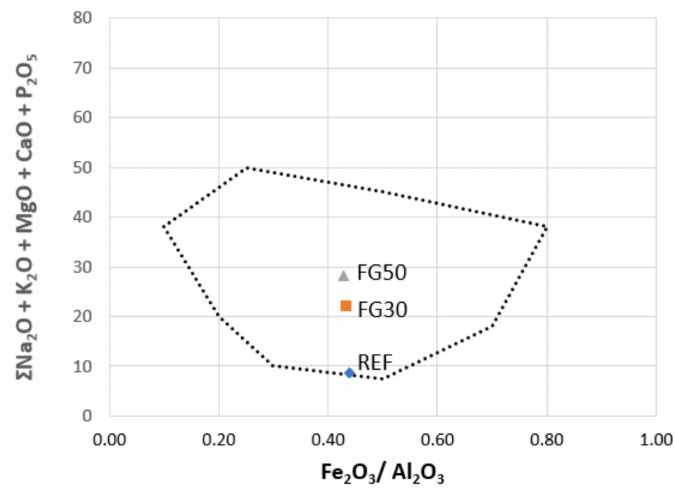
Figure 2. Location of REF, FG30, and FG50 compositions in the Cougny modified predictive